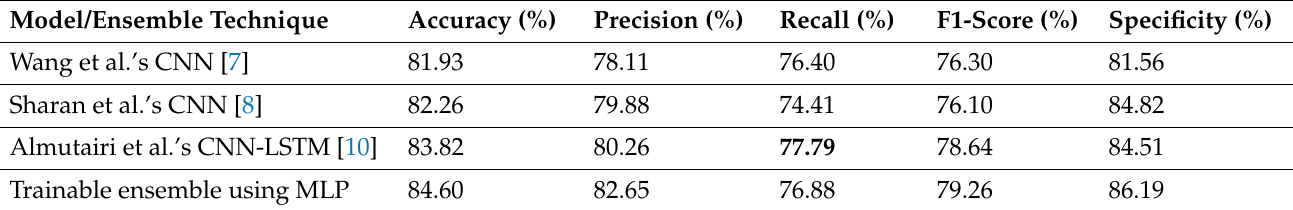
Table 3. Classification performances obtained by all the base models and their ensemble using two-fold cross-validation.